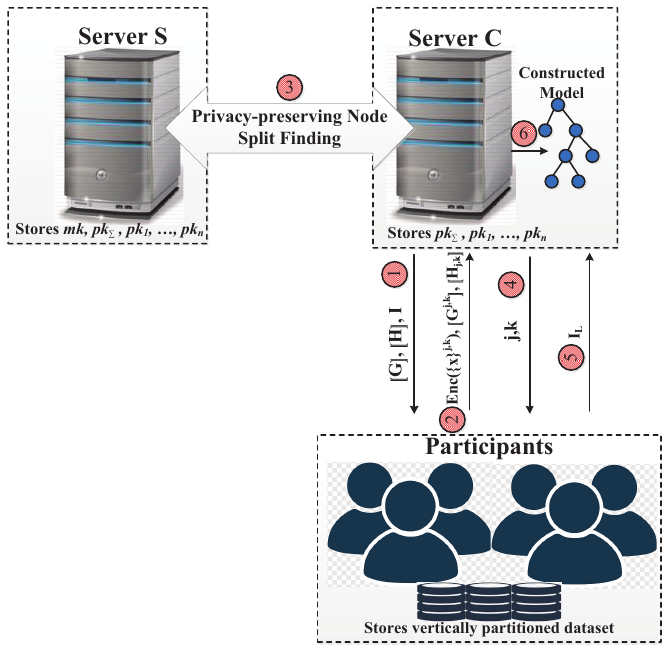
Figure 2. Entities of our proposed